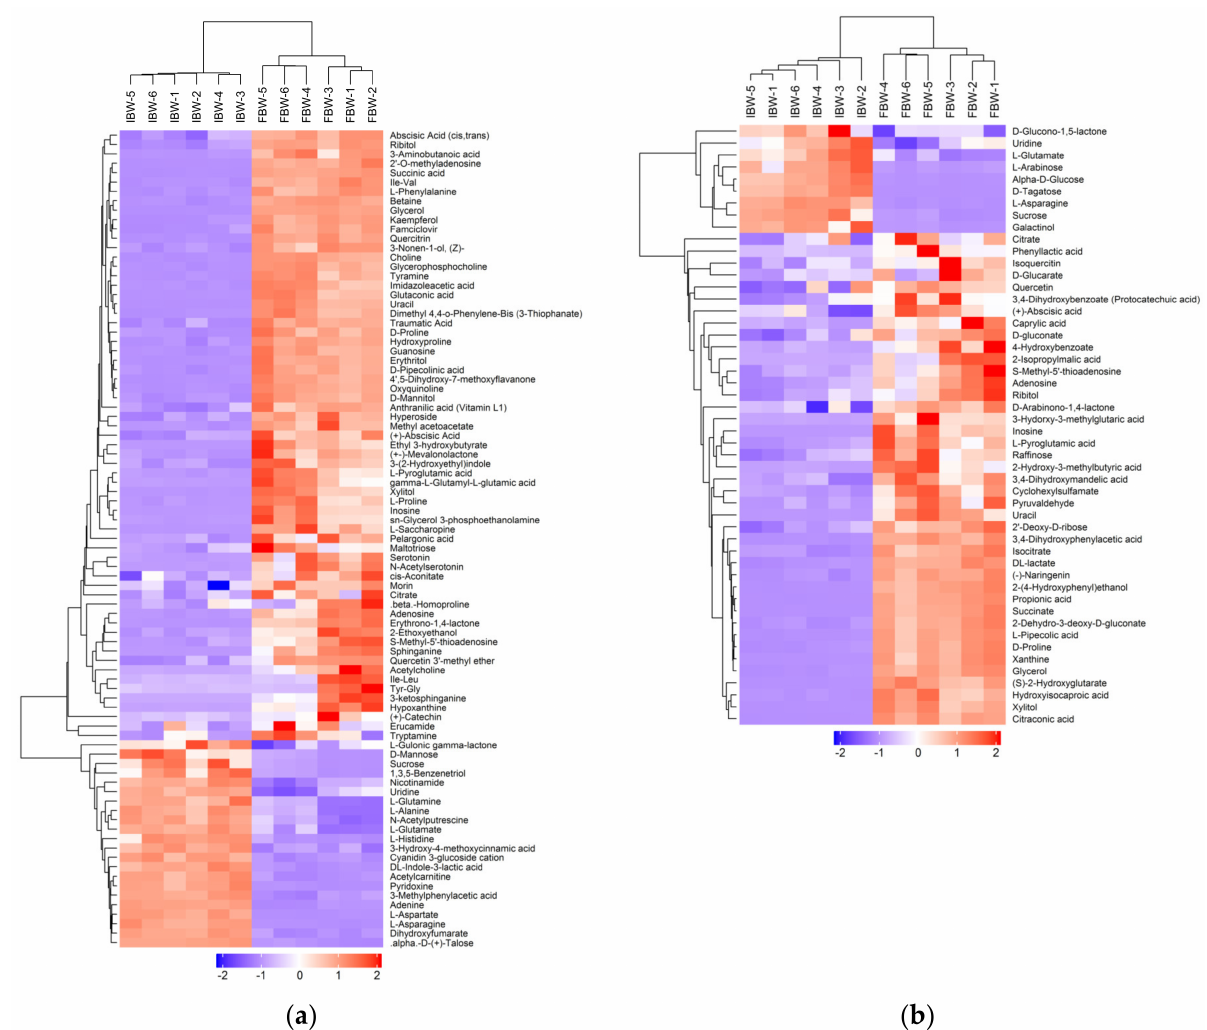
Figure 3. Hierarchical clustering plot of soluble compounds detected by electrospray ionization (ESI), with positive and negative ion modes. ( a ) Detected by positive ion mode; ( b ) detected by negative ion mode.